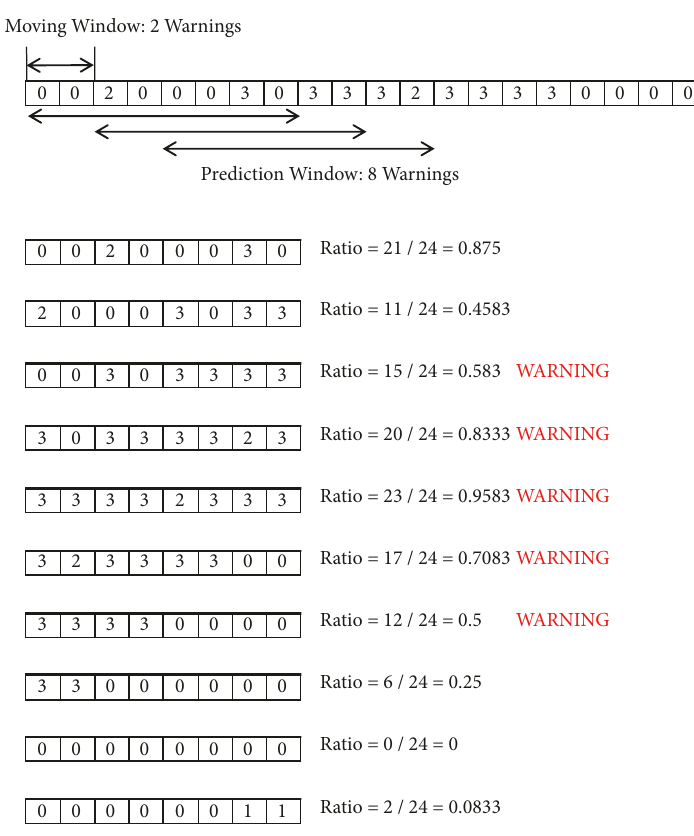
Figure 16: Algorithm results using prediction